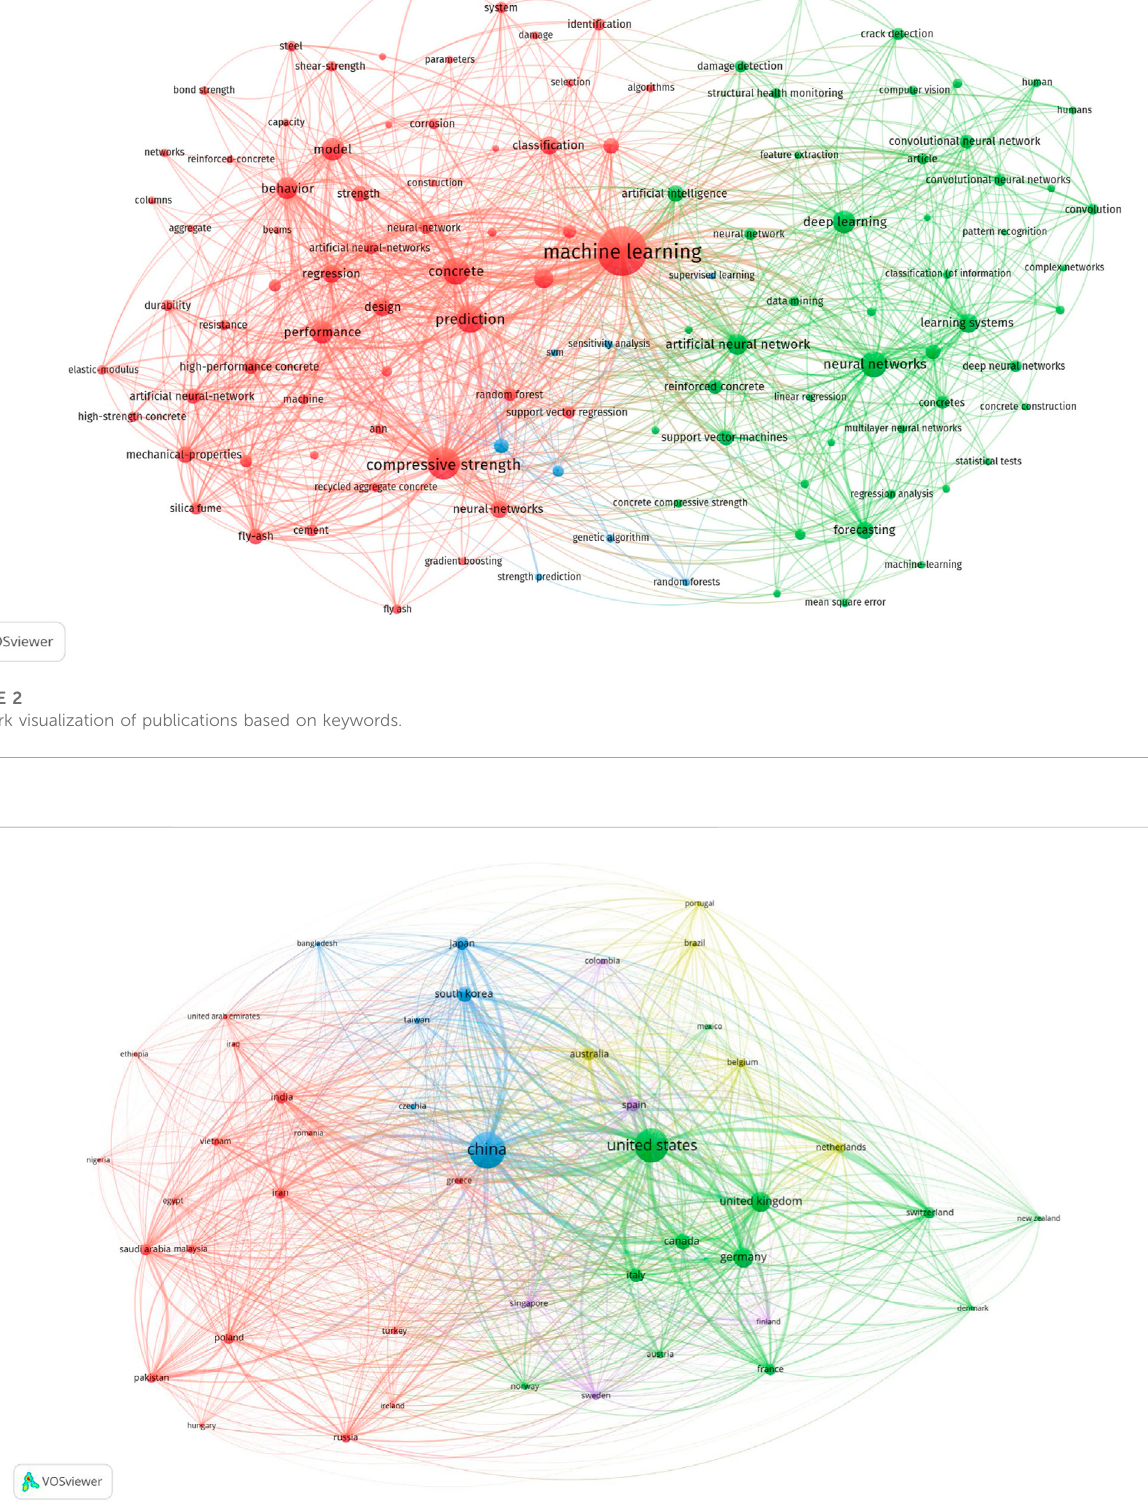
FIGURE 3 Network visualization of publications based on countries of